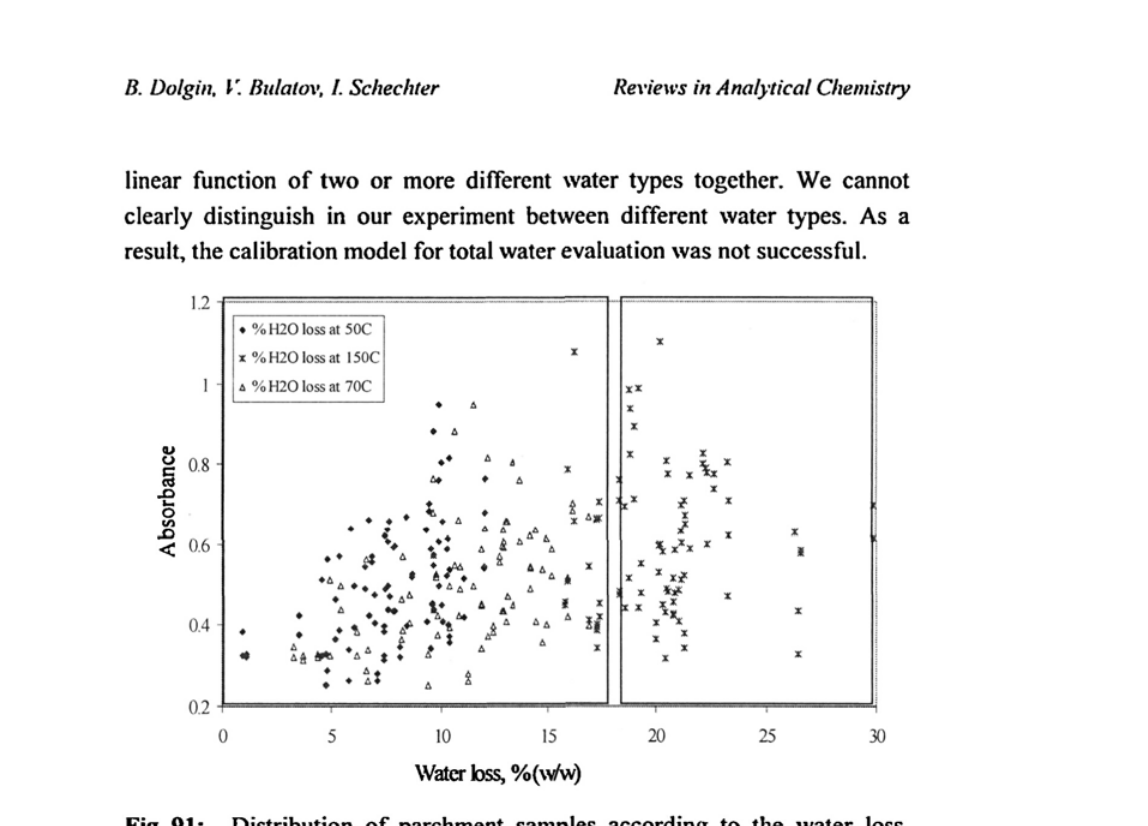
Fig. 91: Distribution of parchment samples according to the water loss. Absorbance was measured at 1907 nm for the surface water and at 1937 nm for the bulk